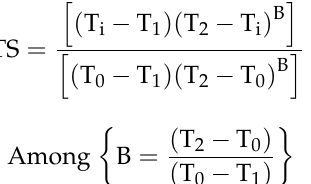
Table 3. Values of related parameters for calculating the sunshine suitability (SS), temperature suitability (TS), and precipitation suitability (PS) at four growth periods of wheat. Parameters JF FIF FS SM b T 0 T 2 Kc